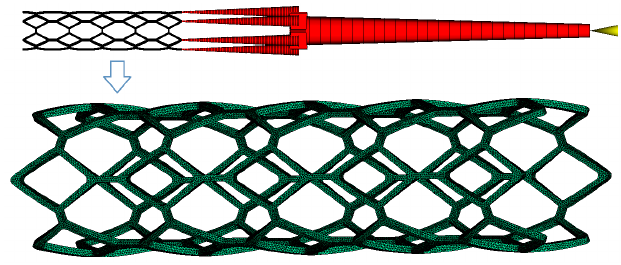
Figure 4. The simulation model of stent injection molding based on the ART18Z platform.